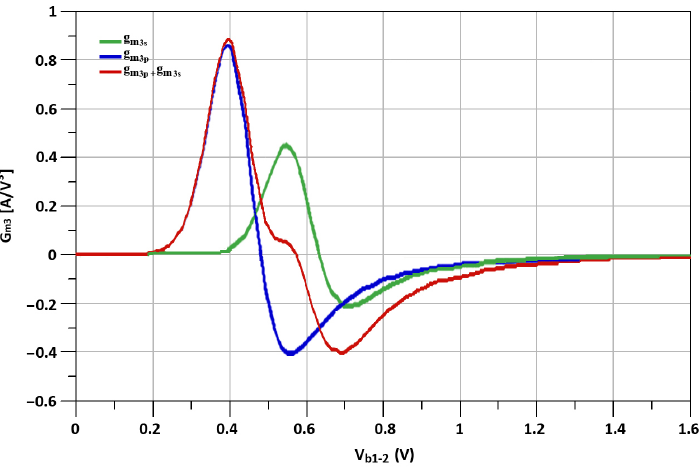
Figure 13. The simulated g m2s , g m2p and g m2s + g m2p of M p and M s transistors.